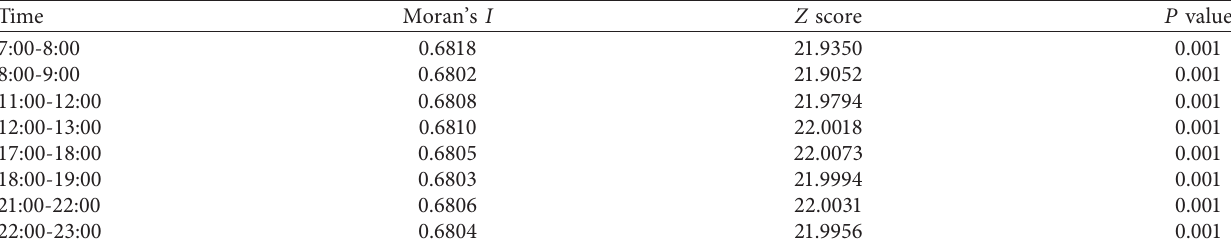
Figure 15: Accessibility at different time intervals. The dotted lines in different colours represent the means of accessibility in the study area at different time intervals. The tag on the bar is the C.V. of the hospital accessibility. Table 6: The results of the spatial autocorrelation analysis.